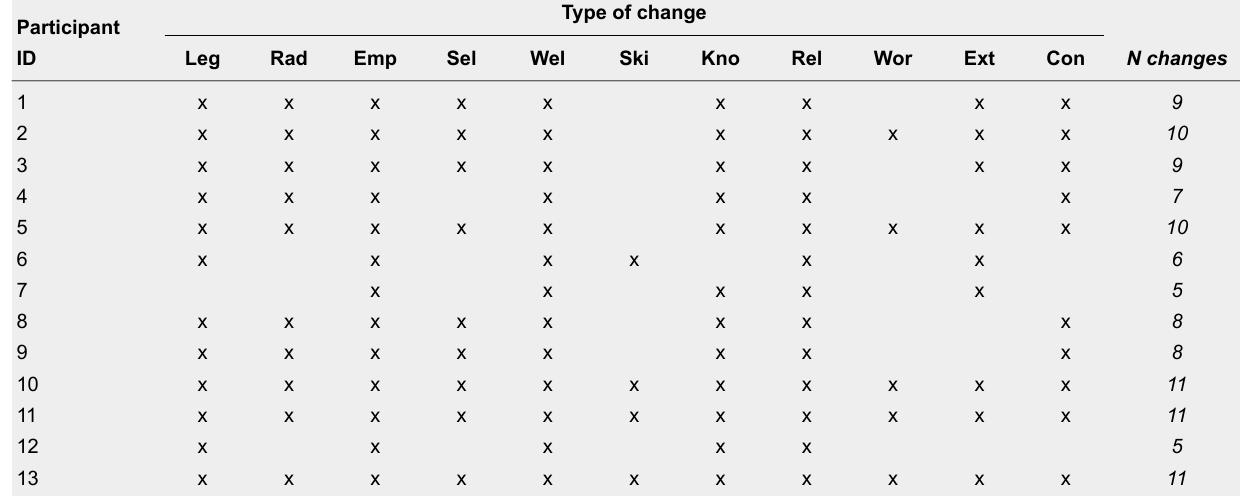
Types of Changes per